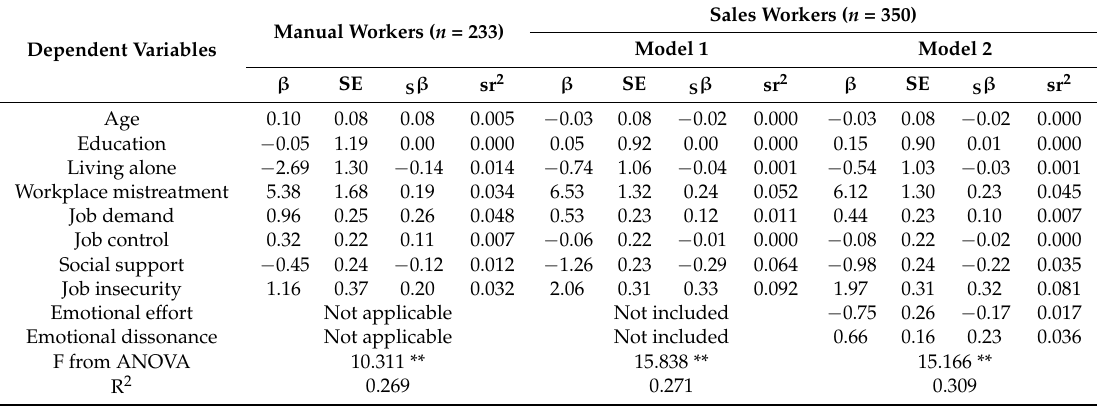
Table 3. Predictors for depressive symptoms among sales workers and manual workers: multiple regression analyses stratified by occupation ( N =